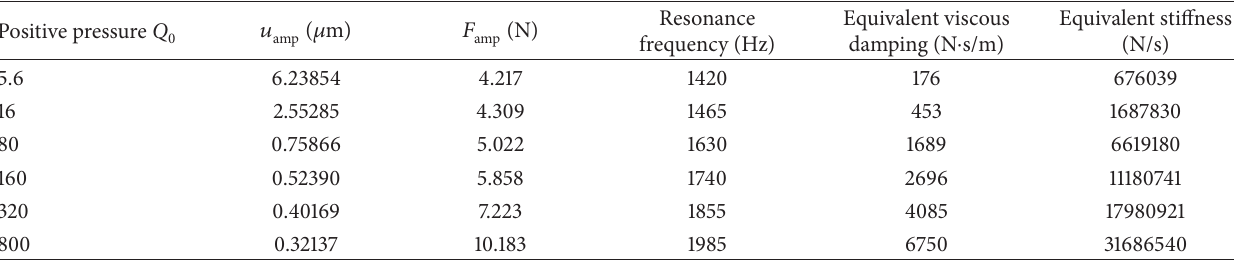
Table 1: Resonance parameters of lacing damper.